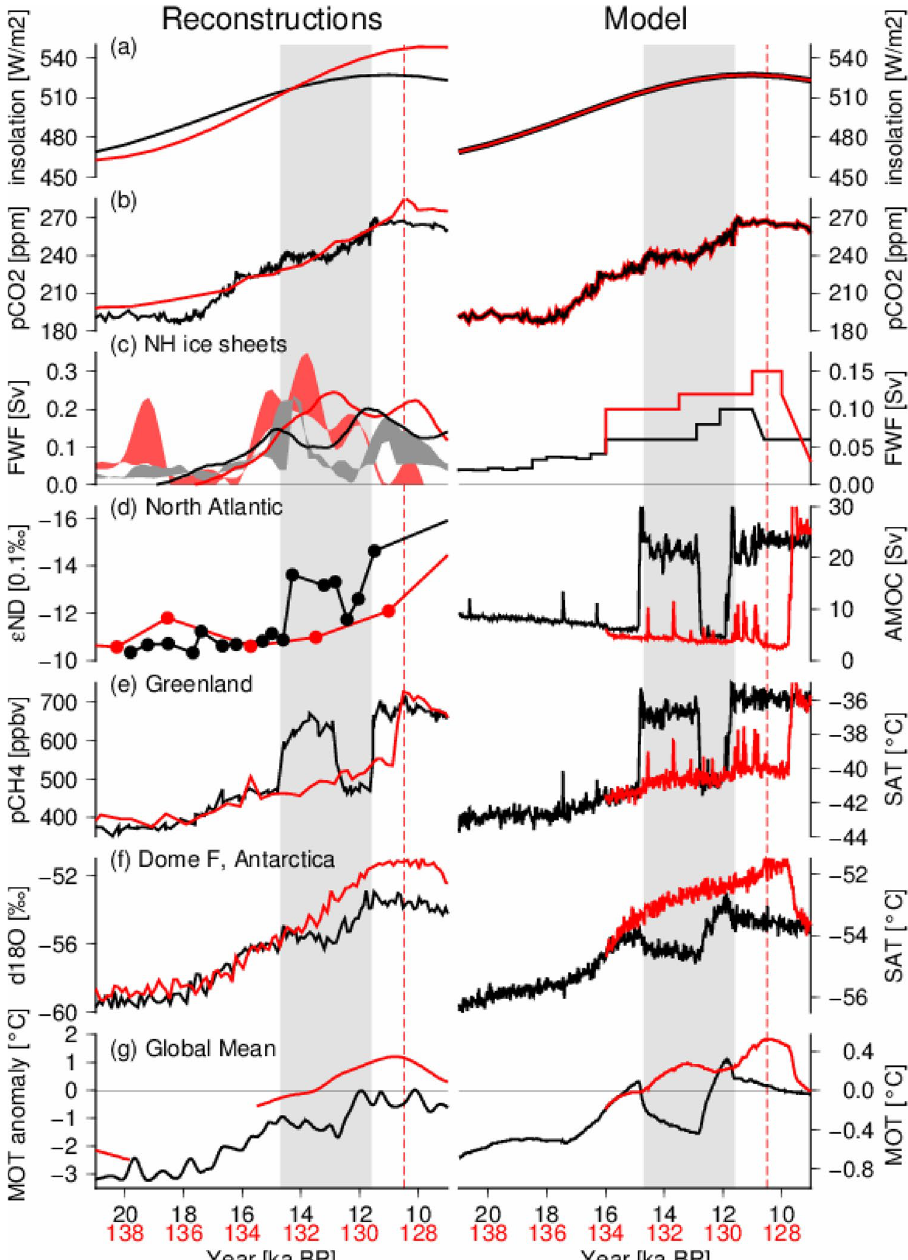
Figure 1. Climate model experimental design and results (right panels) compared with reconstructions (left panels). The black and red lines represent the last and penultimate deglaciations, respectively. The grey shaded areas correspond to the period of the last deglaciation from BA to onset of the Holocene (14.7 to 11.6 ka BP). The vertical red dashed lines (128.5 ka BP) correspond to the onset of the Last Interglacial, following 4 . Left panels: ( a ) Summer solstice insolation at 65° N 36 . ( b ) Atmospheric CO 2 concentrations 37 . ( c ) Northern Hemisphere ice sheet volume loss rate from two ice sheet reconstructions (grey and red shaded bands 4,31 ) and a three-dimensional dynamic ice sheet model (bold lines 38 ). The volume loss rates are calculated from ice sheet volume changes during intervals of 1000 years. ( d ) Neodymium isotopes of the North Atlantic as a proxy of the relative influences of North Atlantic Deep Water and Antarctic Bottom Water, which is an indicator of the AMOC 9,35 . ( e ) Atmospheric CH 439 , which reflects abrupt AMOC changes during deglaciations. ( f ) Antarctic oxygen isotopes at Dome Fuji 34 . ( g ) Global mean ocean temperature based on noble gases (splined “Mix” of Refs. 24,40 ). All ice core records are on the AICC2012 age scale. Right panels: ( c ) Applied freshwater flux in the North Atlantic in two experiments. ( d ) AMOC, defined as the maximum meridional streamfunction of the AMOC between 30° N and 90° N and below 500 m depth. ( e ) Annual mean 2-m air temperature in Greenland (3-point average of GISP2, NGRIP, and NEEM ice cores). ( f ) Annual mean 2-m air temperature at Dome Fuji, Antarctica. ( g ) Global mean ocean temperature. The time series of model results were generated from 20-year